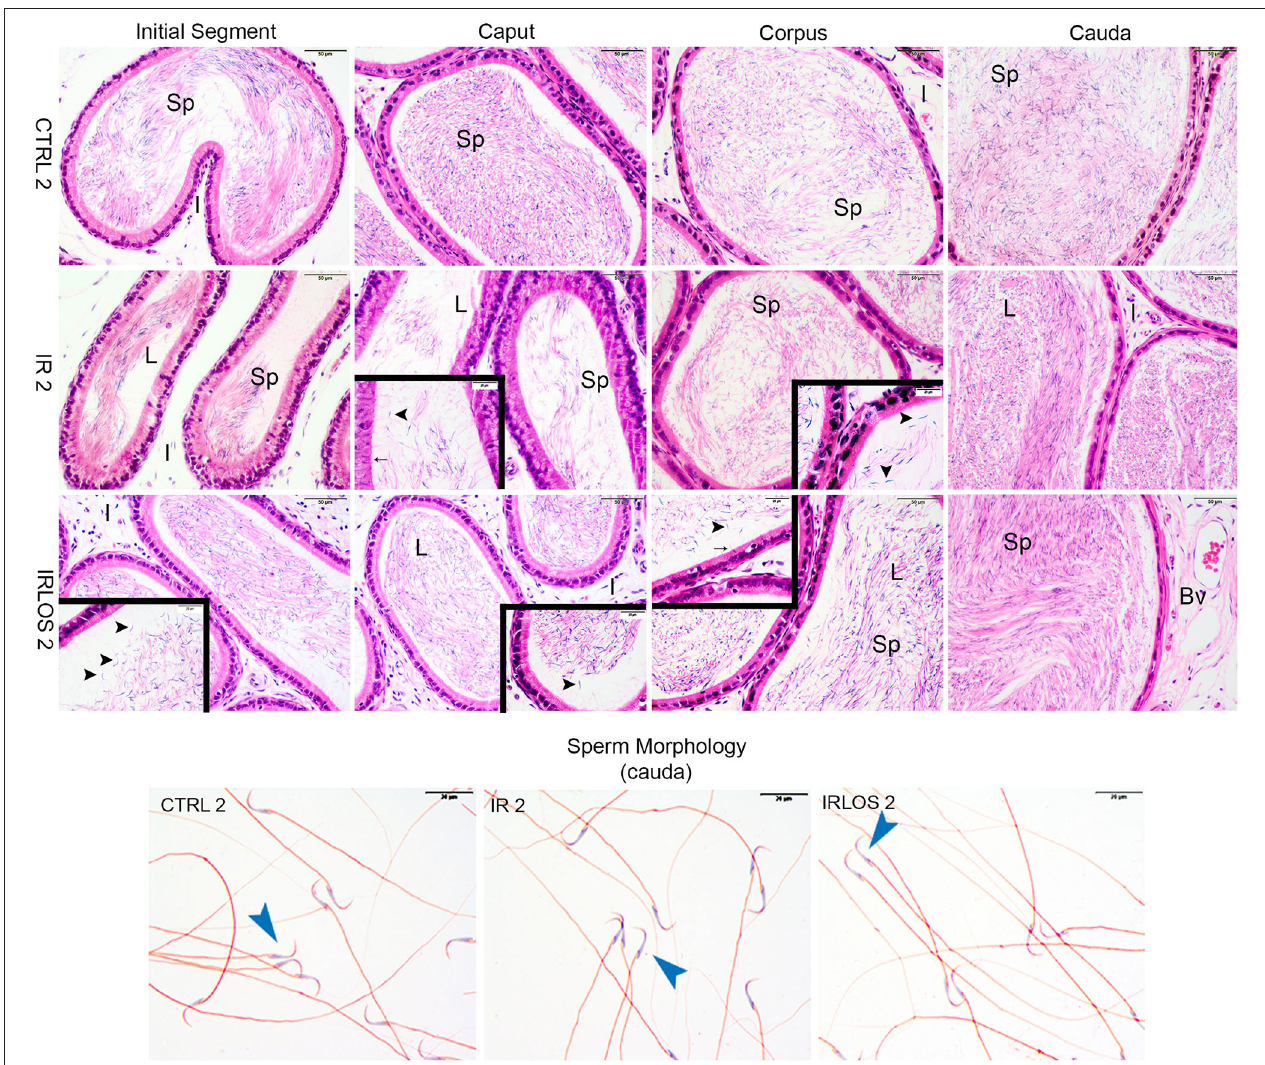
FIGURE 3 | Representative photomicrographs of epididymis and sperm morphology from control (CTRL 2), irradiated (IR 2), and irradiated and treated with losartan (IRLOS 2) groups after 2 days of exposure to the ionizing radiation. In the control group, the epididymis segments exhibited a classic morphology and the lumen showed high sperm (sp) content. Pattern interstitial tissue (I) without inflammatory infiltrate was observed. In the irradiated groups, independently of the treatment with losartan, the epididymis segments (initial segment, caput, corpus, and cauda) exhibited histological characteristics similar to the control, with high intraluminal sperm density (L). No evidence of inflammatory infiltrate was observed in the interstitial tissue. An apparent damage signal in some tubules was the presence of isolated heads of sperm ( ◮ ) and phagocytosis of sperm ( → ). Isolated sperms from cauda of epididymis exhibited normal forms in all analyzed groups. Bv, blood vessels; ◮ , sperm with normal morphology. Scale bar, 50 µ m, insets, 20 µ m. Staining: Epididymis, hematoxylin and eosin; Sperm,